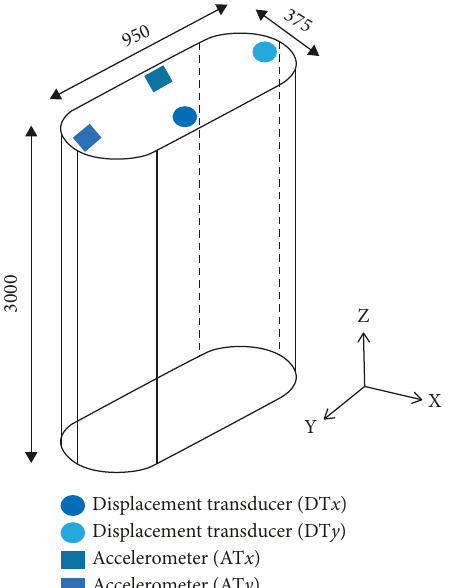
Figure 3: Instrumentation of data acquisition devices for experimental pier specimen (unit: mm).